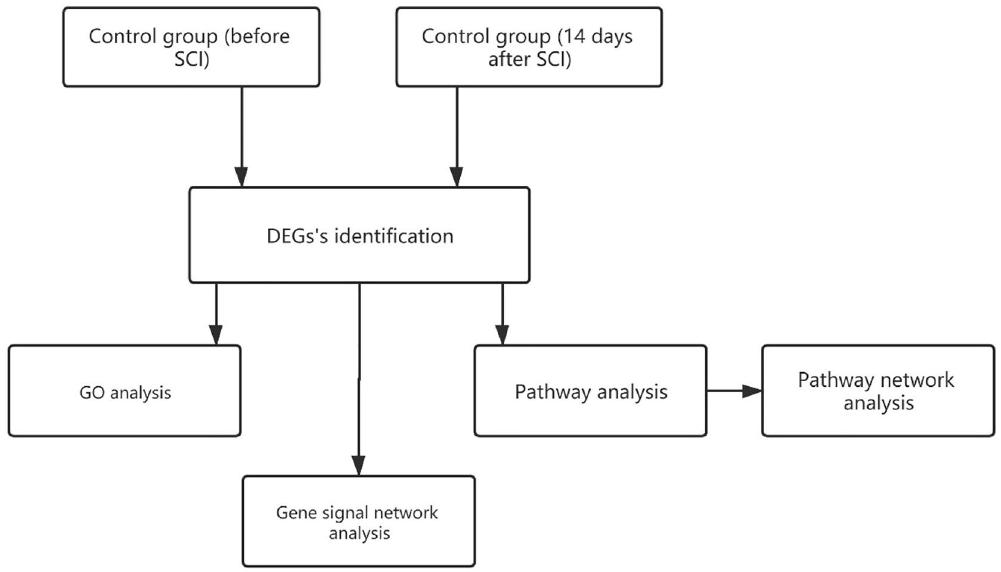
Figure 6. Flowchart of the bioinformatic analysis in the present study. SCI, spinal cord injury. DEGs, differentially expressed genes. n =